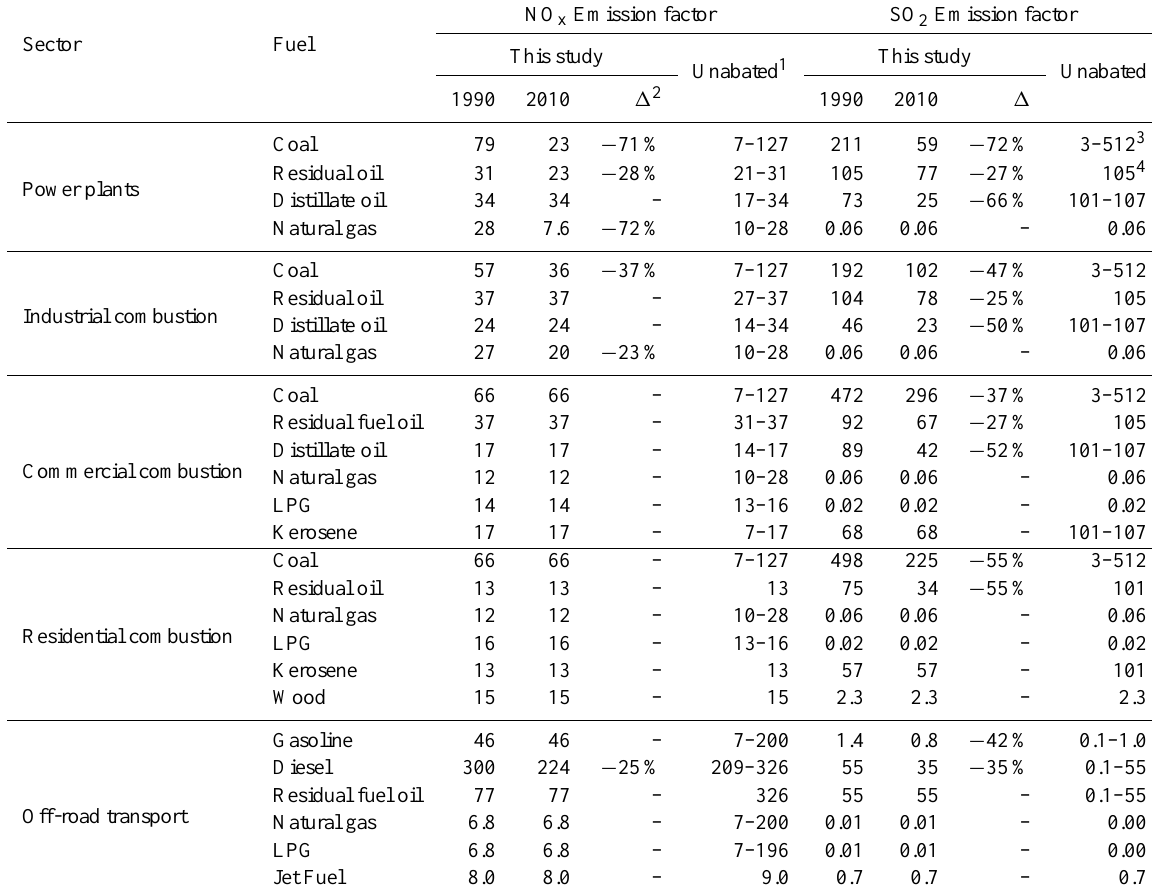
Table 3. Summary of NO x and SO 2 emission factors in energy-related stationary and non-road sectors (unit: 0.01lb/MMBtu).